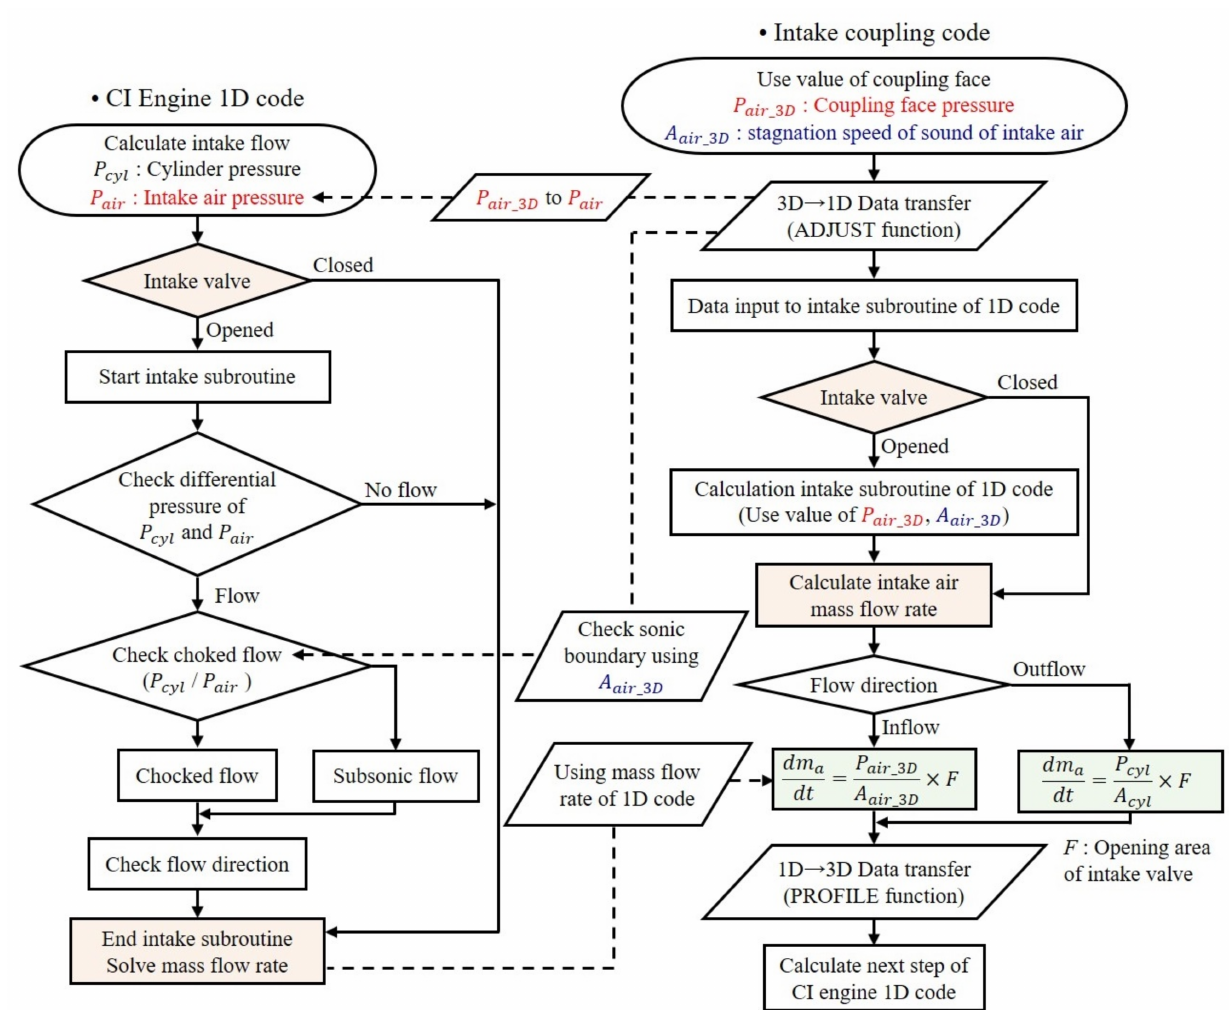
Figure 4. Flow chart of the 1D–3D coupling algorithm for the air-intake